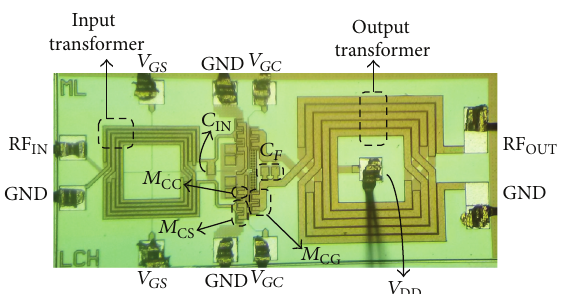
Figure 6: Photograph of the newly designed power